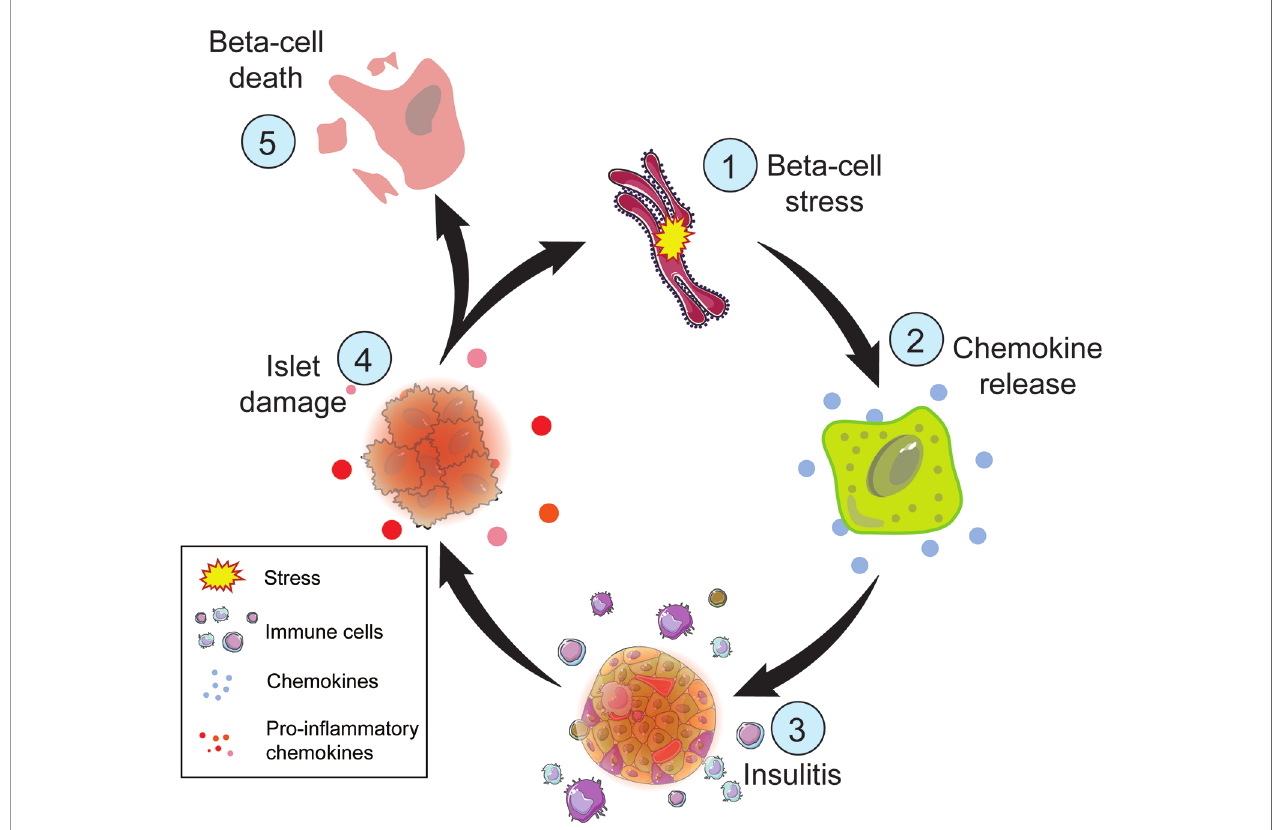
FIGURE 3 | Steps of beta-cell death in T1D. Metabolic demand of nutrient challenge results in ER and oxidative stress (1) followed by chemokine release by the beta-cell (2). Chemokines attract immune cells (3), such as macrophages and T cells, which can damage the islet (4) directly though T cell interactions and indirectly through the release of in fl ammatory cytokines and reactive oxygen species. Cellular damage exacerbates ER and oxidative stress perpetuating this cycle. The inability to restore cellular homeostasis will result in beta-cell death